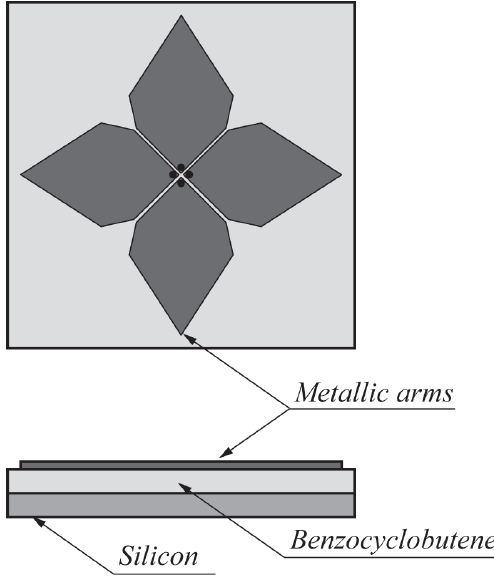
Figure 21. Configuration of the fourtear antenna structure (redrawn from [85]). Dark gray top metal face, medium gray bottom dielectric substrate, and light gray center dielectric